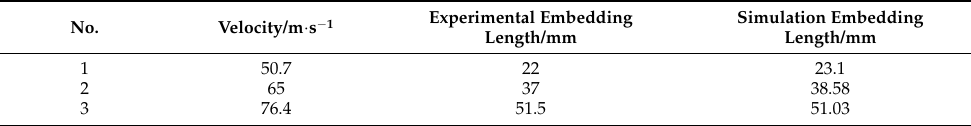
Table 2. Harpoon embedding experiment.